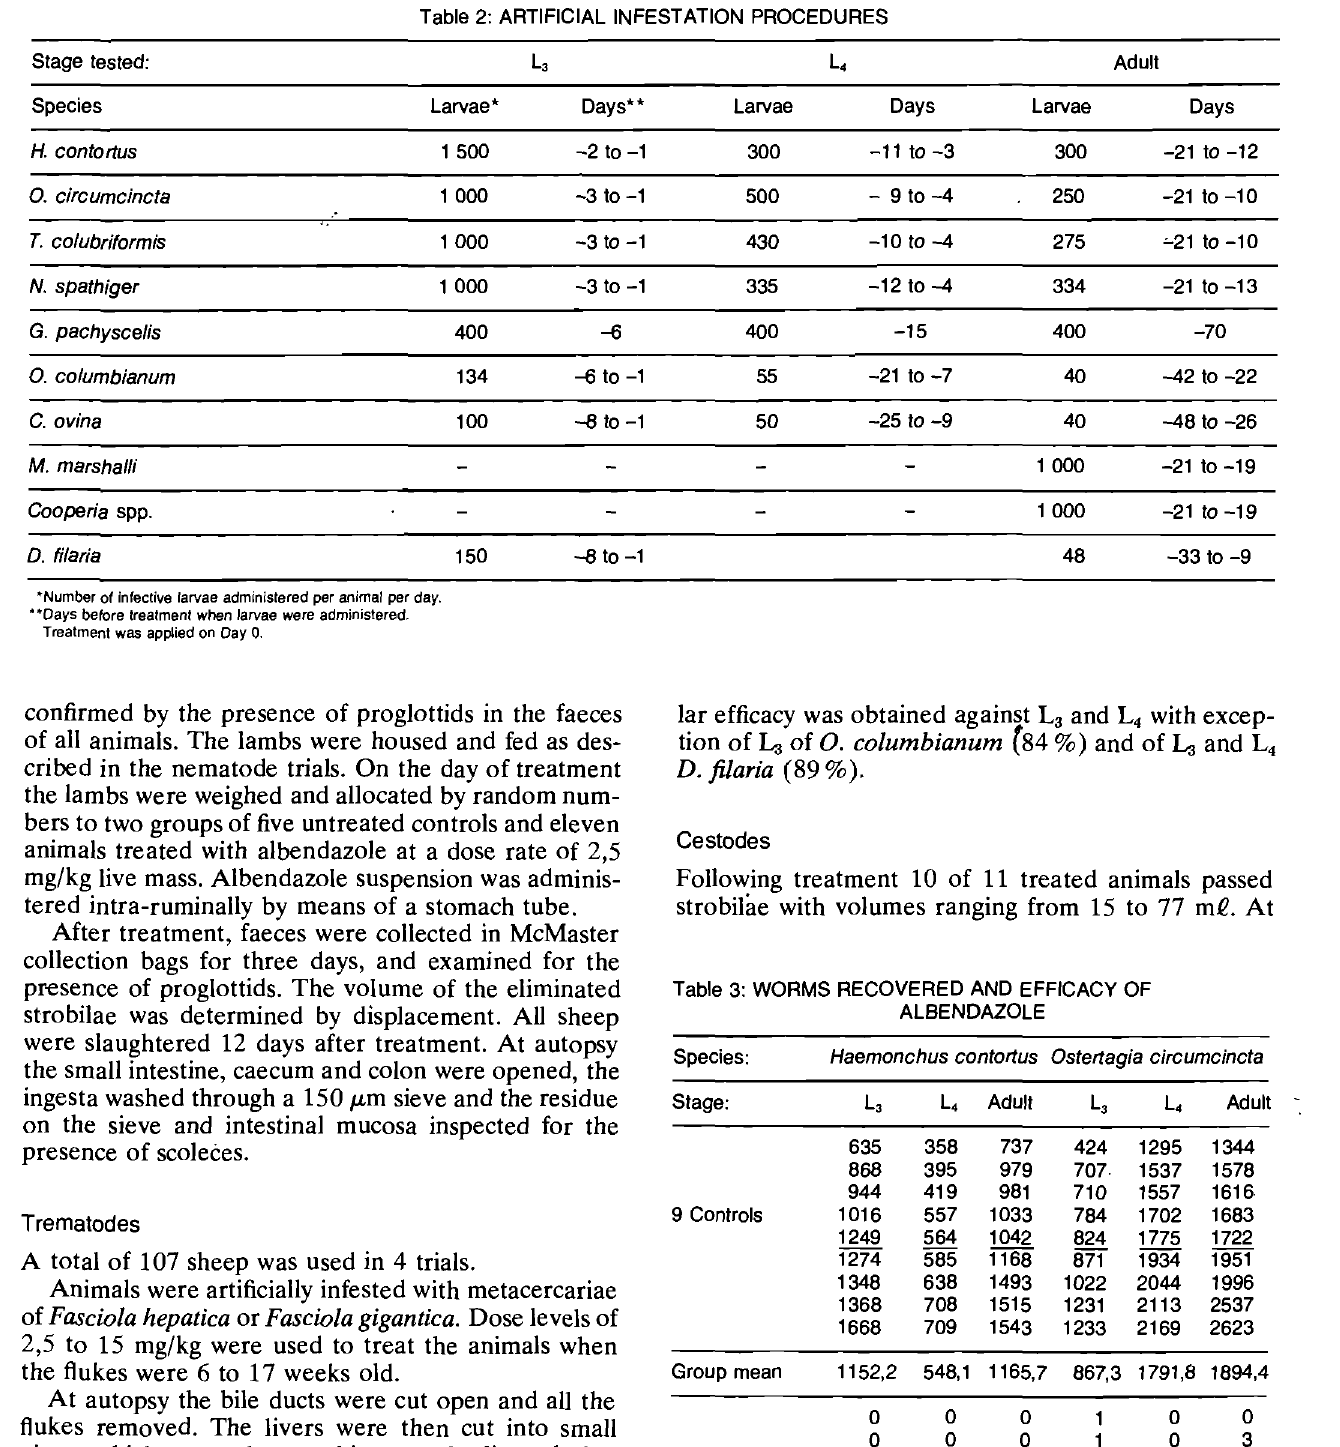
Table 2: ARTIFICIAL INFESTATION PROCEDURES